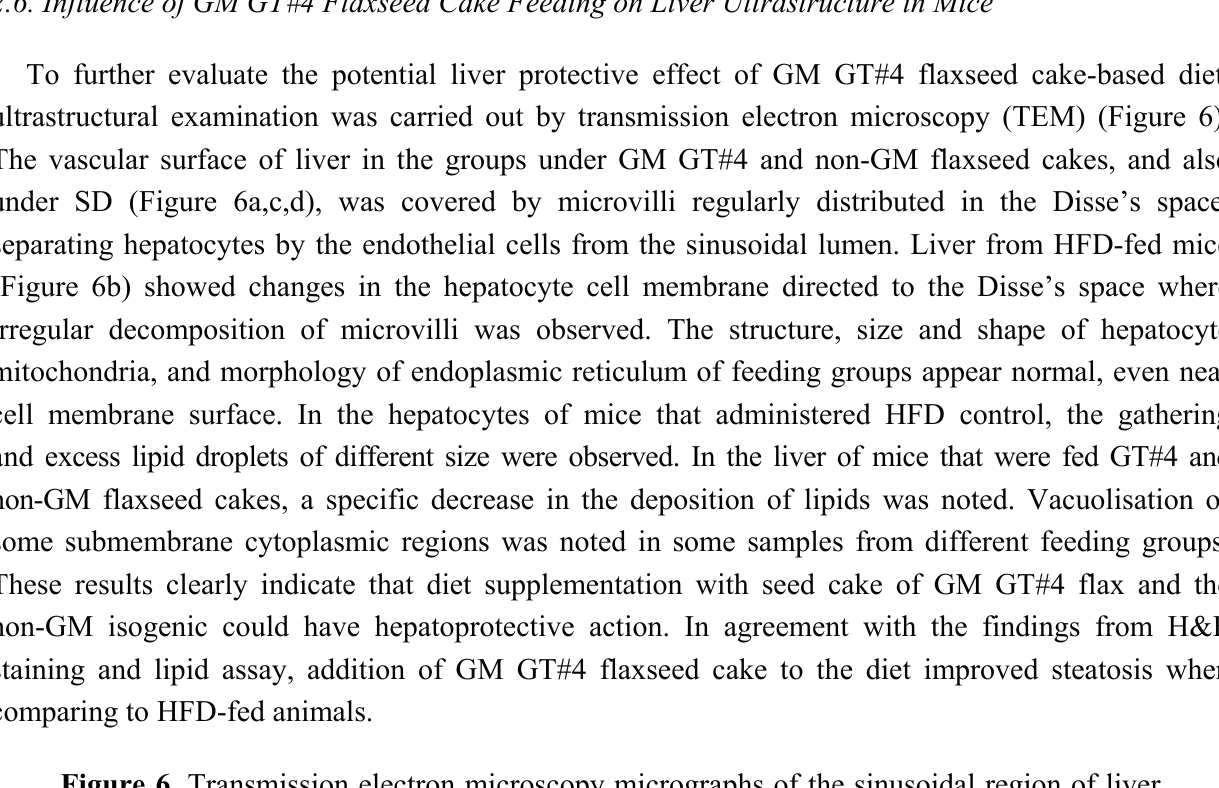
Figure 6. Transmission electron microscopy micrographs of the sinusoidal region of liver of mice fed the diets: ( a ) SD; ( b ) HFD; ( c ) Linola; and ( d ) GT#4. Mitochondrium (M), rough endoplasmic reticulum (RER), sinusoidal lumen (SL), space of Disse (D), endothelial cell (EC), erythrocyte (ER), lipid droplet (L), endothelial fenestrae